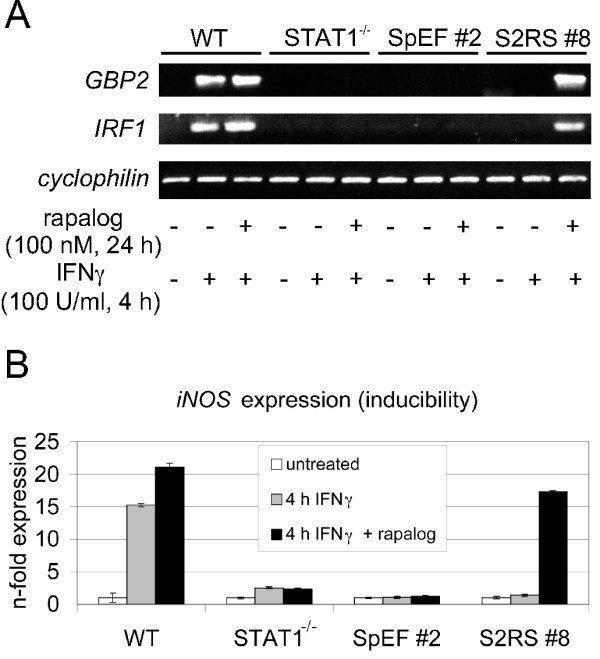
Inducible IFNγ-mediated induction of STAT1 target genes in MEF cell lines. Cells were treated with 100 nM rapalog for 24 h or left untreated and subsequently stimulated with IFNγ (100 U/ml) for 4 h or left untreated. Total RNA was used for RT-PCR analysis for GBP2 and IRF1 expression; cyclophilin was used as endogenous control (A). Quantitative RT-PCR was performed for iNOS expression, HPRT was used for normalization; one representative of two independent experiments is shown (B).